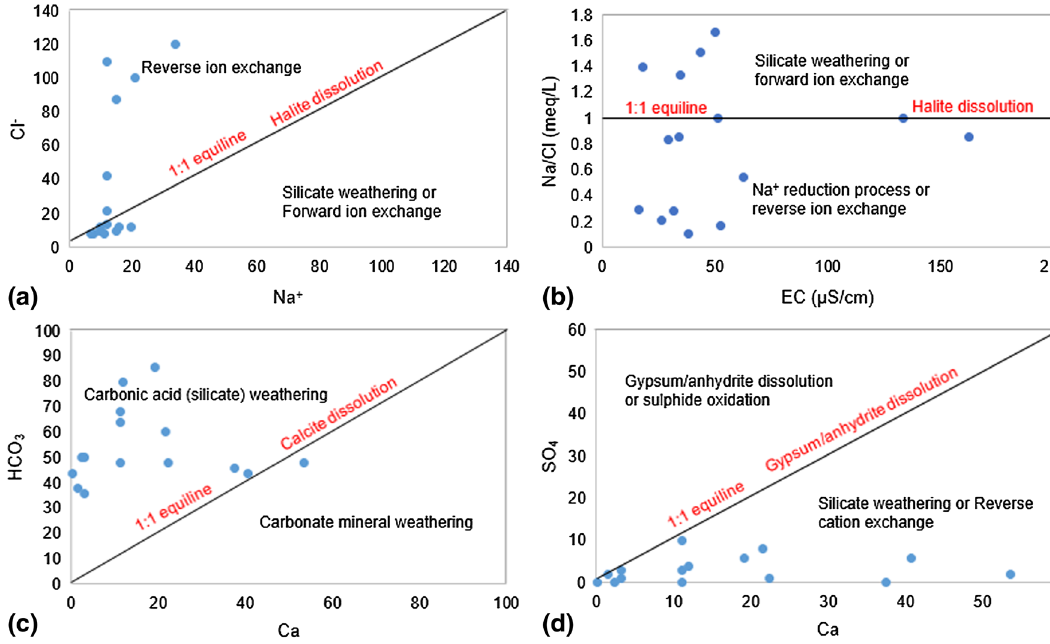
Fig. 9 Scatter plots (mg/L) for: a Na versus Cl, b Na/Cl versus EC, c Ca versus HCO